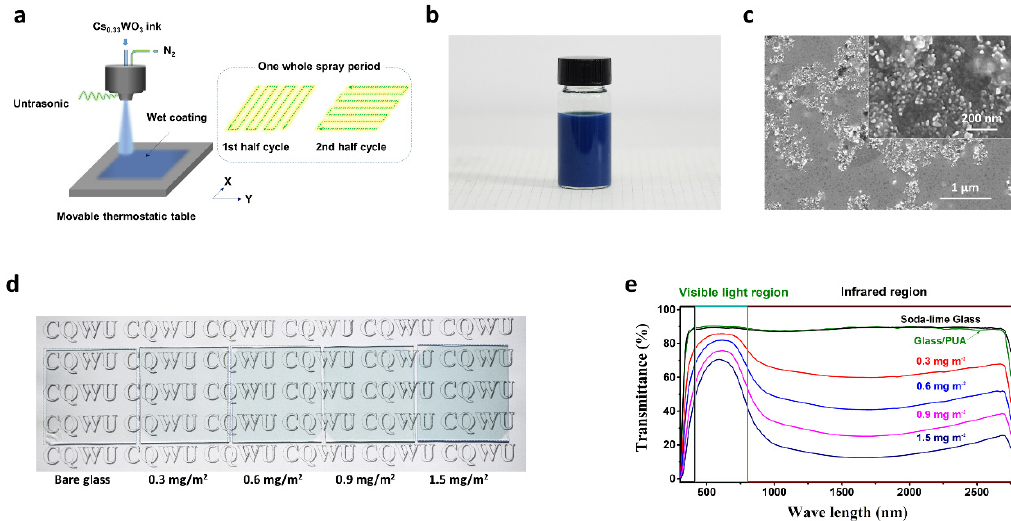
Figure 5. Spray deposition of Cs 0.33 WO 3 /polyurethane acrylate (PUA) composite coatings: ( a ) a sketch for spray deposition, ( b ) Cs 0.33 WO 3 ink, SEM micrographs of ( c ) dried Cs 0.33 WO 3 ink, and ( d ) a photograph and ( e ) UV–Vis–IR transmittance of Cs 0.33 WO 3 / PUA composite coating with Cs 0.33 WO 3 photograph and ( e ) UV–Vis–IR transmittance of Cs 0.33 WO 3 /PUA composite coating with Cs 0.33 WO 3 concentration ranging from 0.3–1.5 mg m − 2 concentration ranging from 0.3–1.5 mg m − 2 .